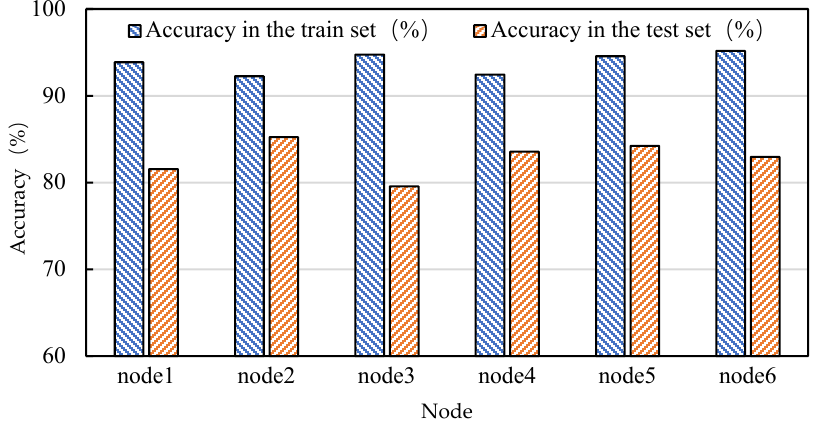
Figure 15. Accuracy of each node in the training set and test set.